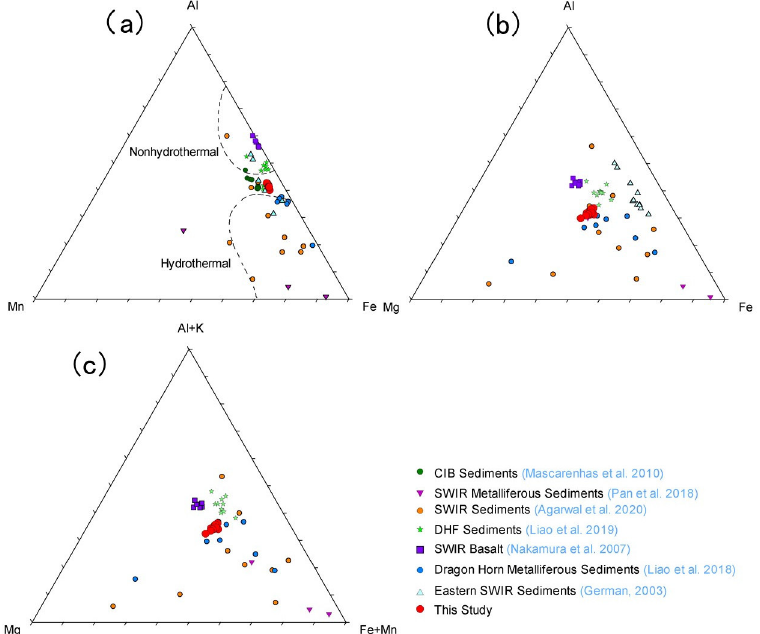
Figure 10. ( a ) Fe-Mn-Al ternary diagram (modified from [54]). ( b ) Fe-Mg-Al ternary diagram. ( c ) Al + K-Mg-Fe + Mn ternary diagram for BC-10 core and comparison with other studies. Data points are taken from different sources, Metalliferous Sediments from Central Indian Ocean (CIB) [39], Metalliferous Sediments, SWIR [13,20], Duanqiao-1 hydrothermal field Sediments [19], Dragon Horn Metalliferous Sediments [18], SWIR Basalt [53], Eastern SWIR Sediments [15].